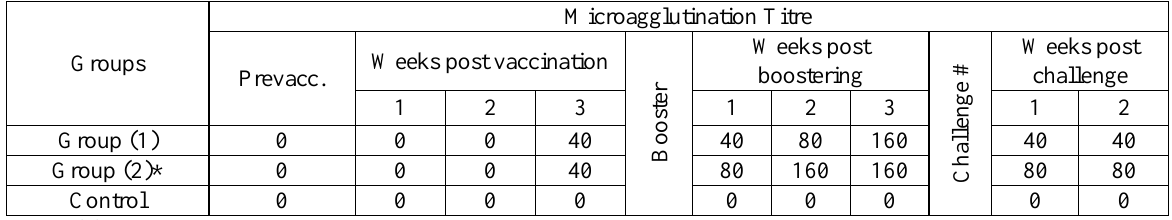
Table 2: Microagglutination titer in sera of vaccinated turkey poults using O78 antigen and challenged with E.coli serotype O78: